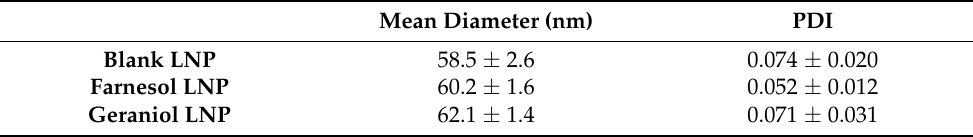
Table 2. Particles size distribution properties of the blank and terpene alcohols-loaded LNPs. PDI (polydispersity